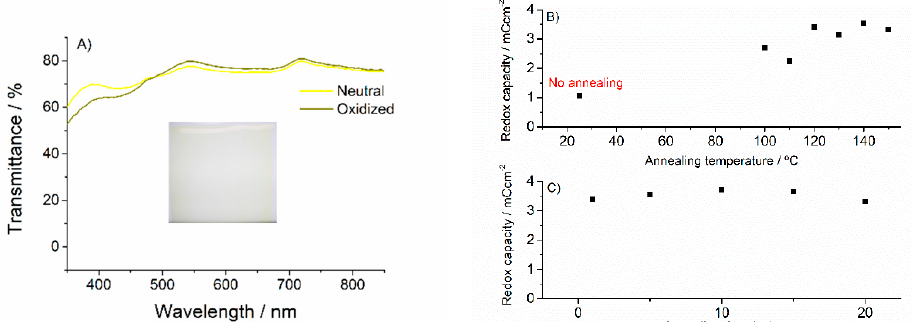
Figure 3. ( A ) Visible transmittance spectra of the obtained V 2 O 5 films in their neutral and oxidized states. Inset: a picture of one film as deposited. ( B ) Redox capacity of V 2 O 5 films for different annealing temperatures (no annealing (25 °C) point is included). ( C ) Redox capacity of V 2 O 5 films for different annealing times.